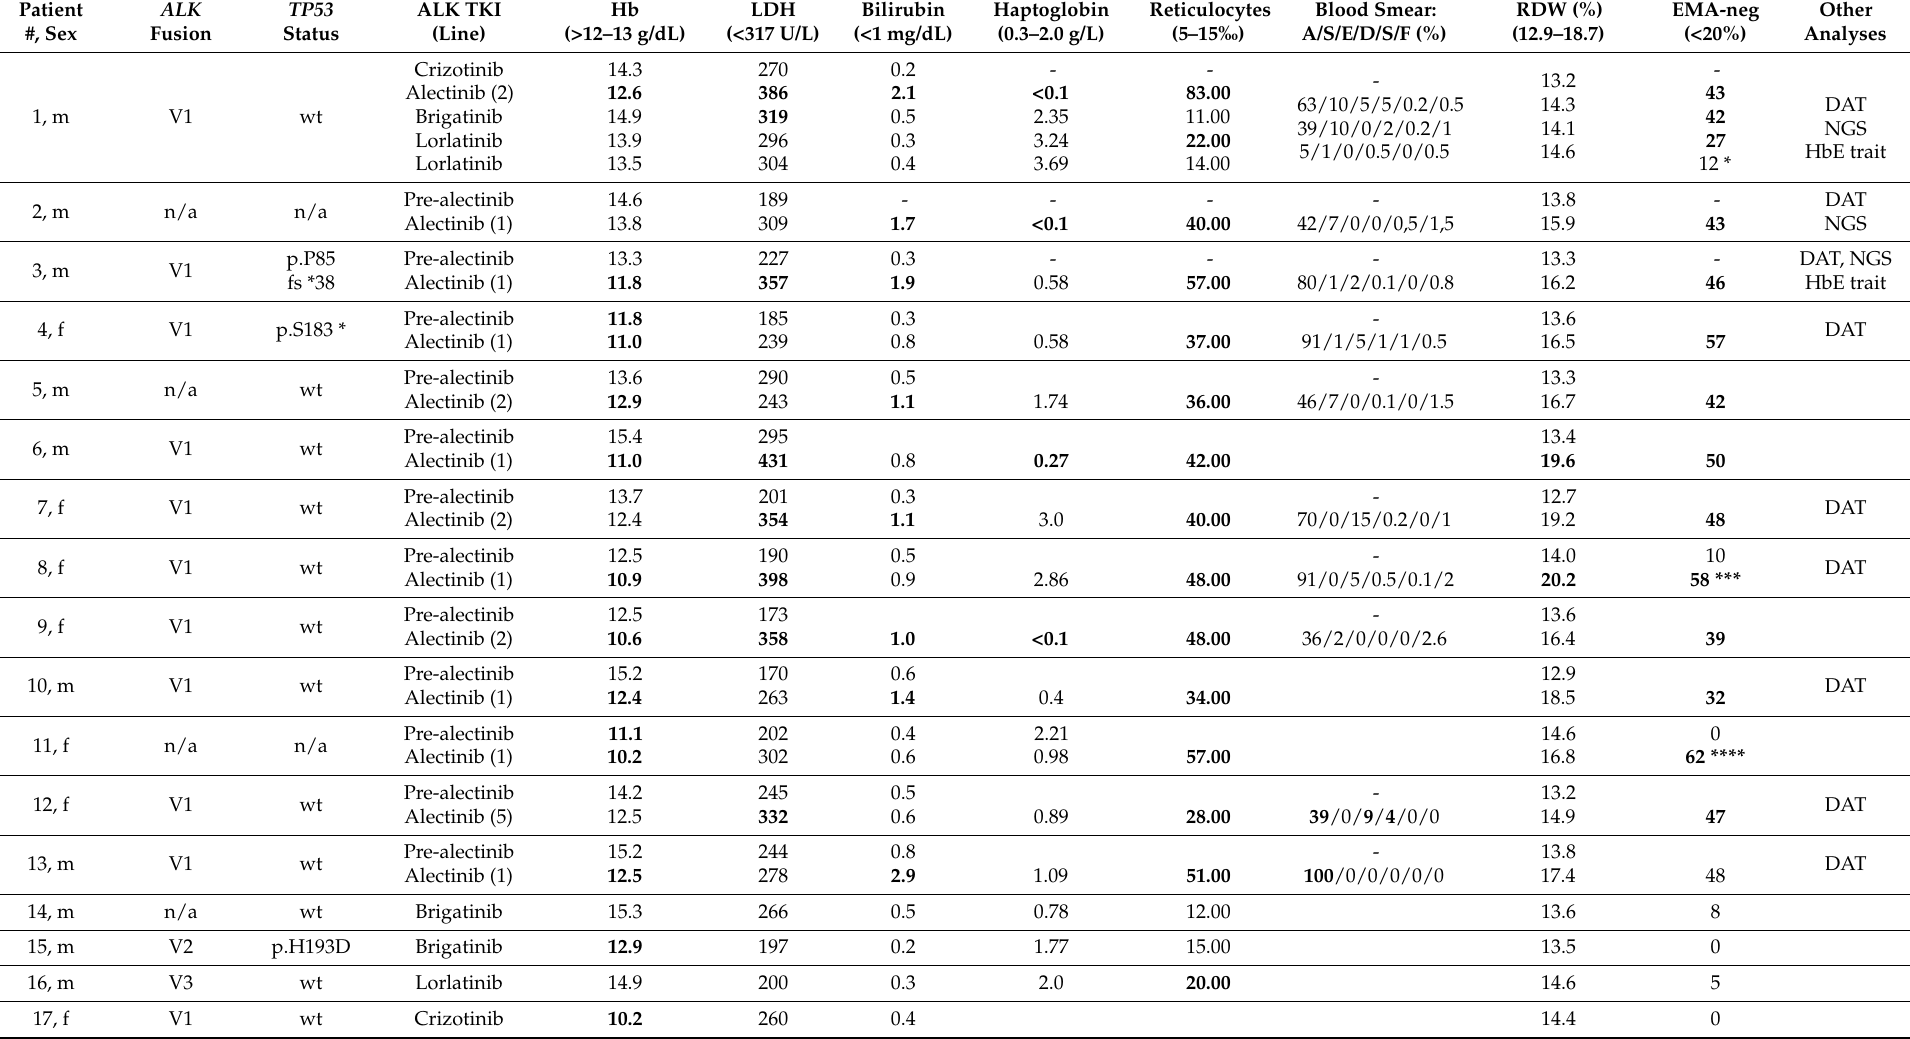
Table 1. Clinical, molecular, and laboratory data. The reference values for each parameter are given in parentheses. Pathologic values are highlighted in